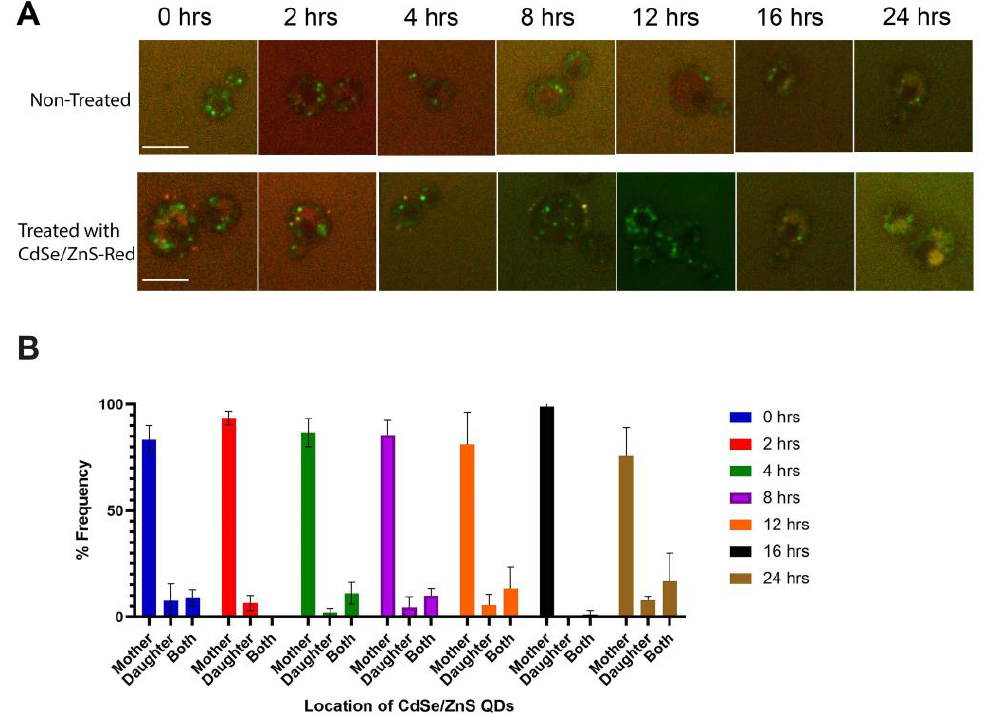
Figure 1. QDs’ external association with yeast. Green signals are expressed Vps10-GFP and red signals are CdSe/ZnS QDs. The size bar is equivalent to 5 µ m. ( A ) QDs attach to the surface of yeast cells. ( B ) Percent of cells (% Frequency) that had QDs attached to mother site, daughter/budding site, or at the neck/both mother and daughter